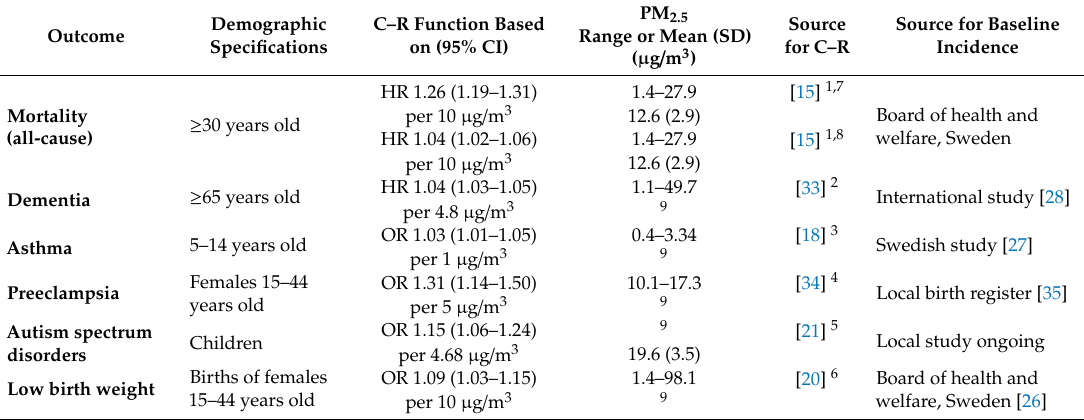
Table 2. Epidemiological associations underlying concentration–response (C–R) functions used in the calculations for this HIA, descriptive and source information and additional health outcome incidence